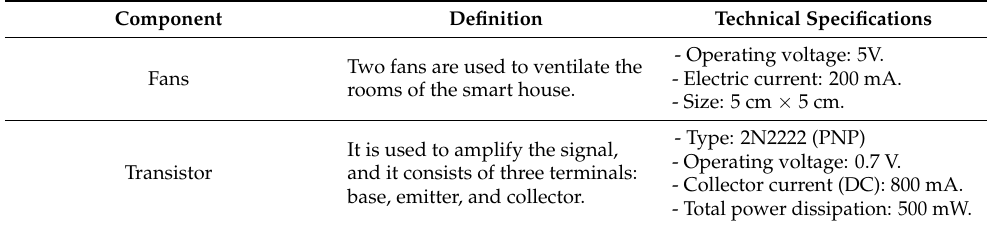
Figure 6. The graphical user interface used to control the speed of the fans.